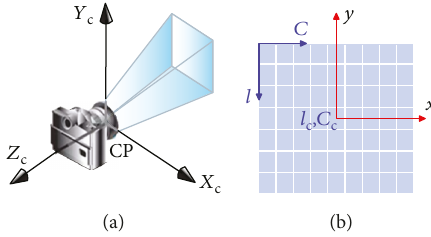
Figure 11: Reference systems: (a) camera axes originating from the perspective center (CP) and (b) image axes originating from the upper left pixel and the center pixel.